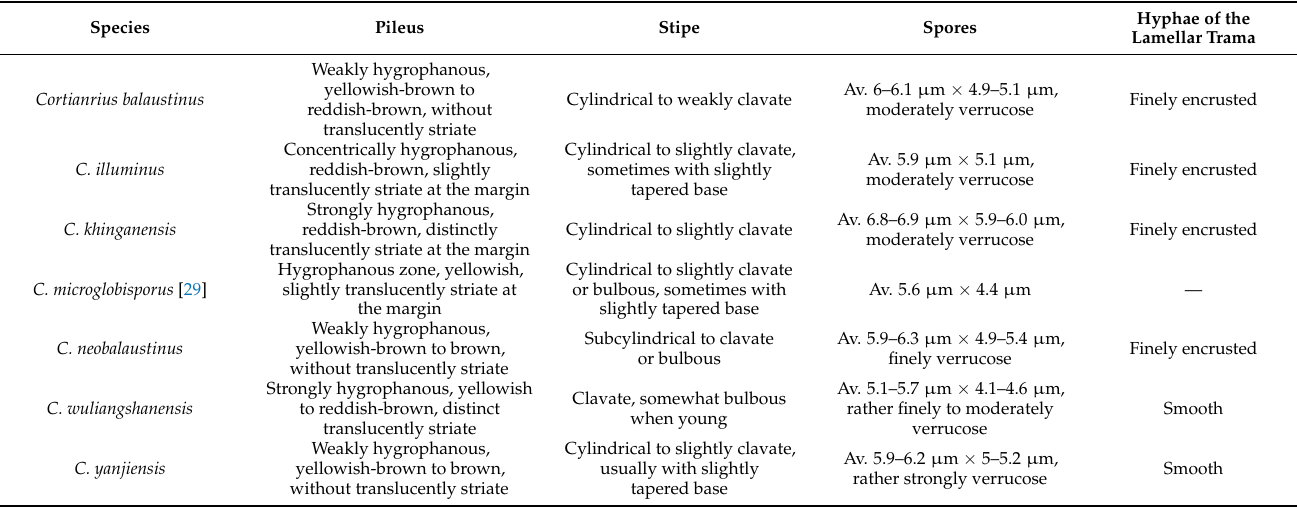
Table 2. Morphological comparisons of the new species and their similar species in sect. Illumini